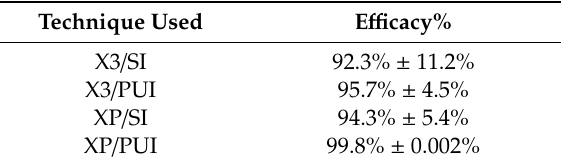
Table 1. E ffi cacy of Ca(OH) 2 removal using di ff erent techniques. The e ffi cacy is presented as the percentage of the volume of removed Ca(OH) 2 from the root canals after the use of di ff erent removal methods.